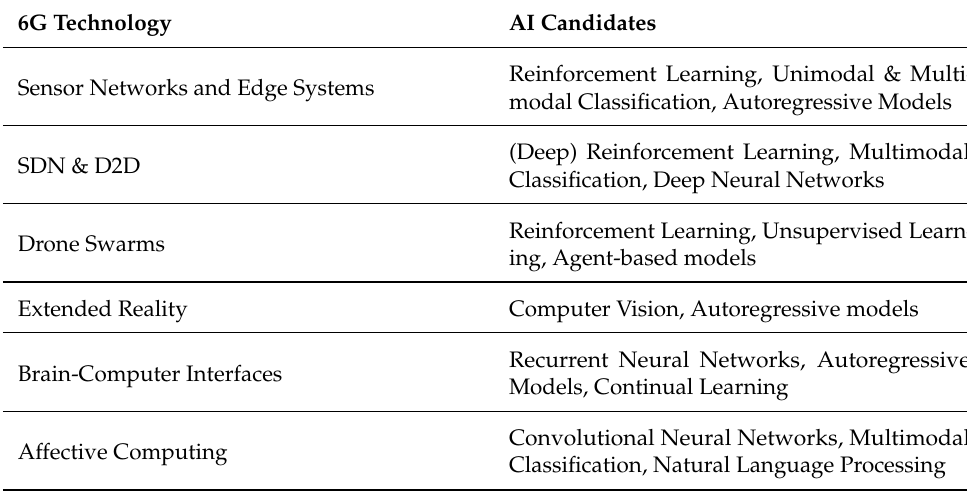
Table 2. AI candidates for the 6G